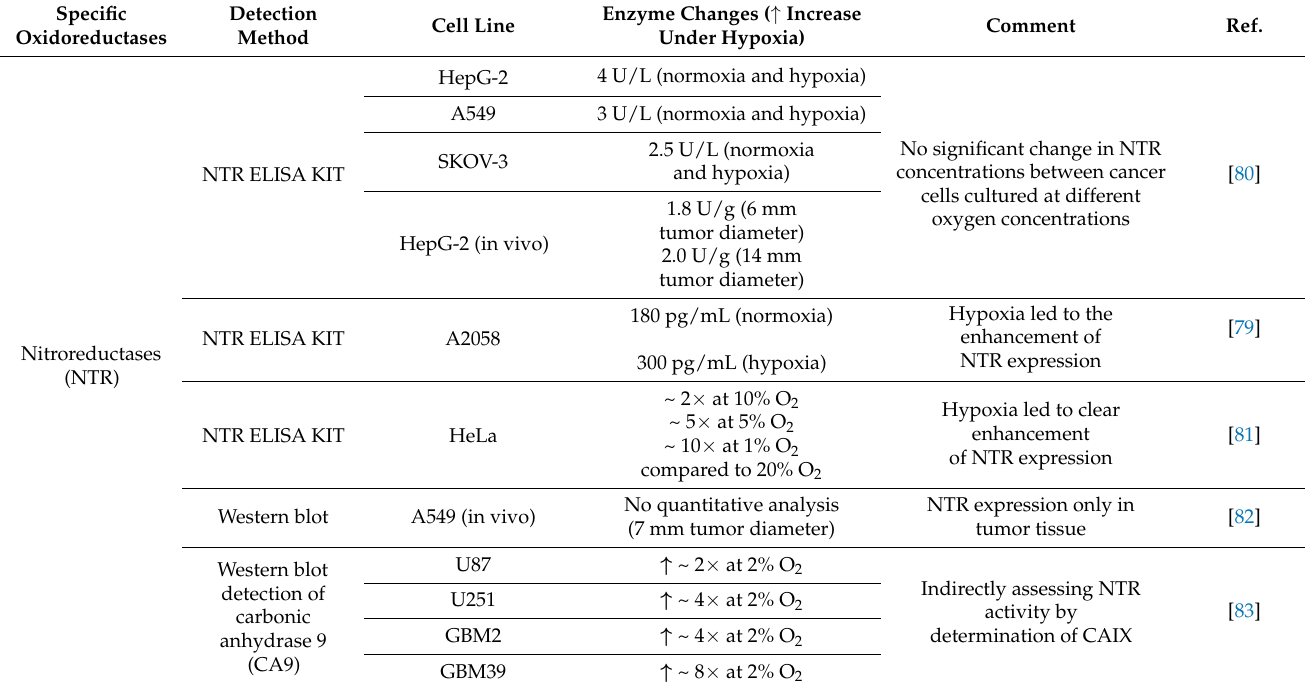
Table 2. Information on the evaluation of the expression or activity of specific oxidoreductases in vitro or in vivo under different oxygen concertation conditions using various biochemical methods. If not otherwise stated, cancer cell lines were